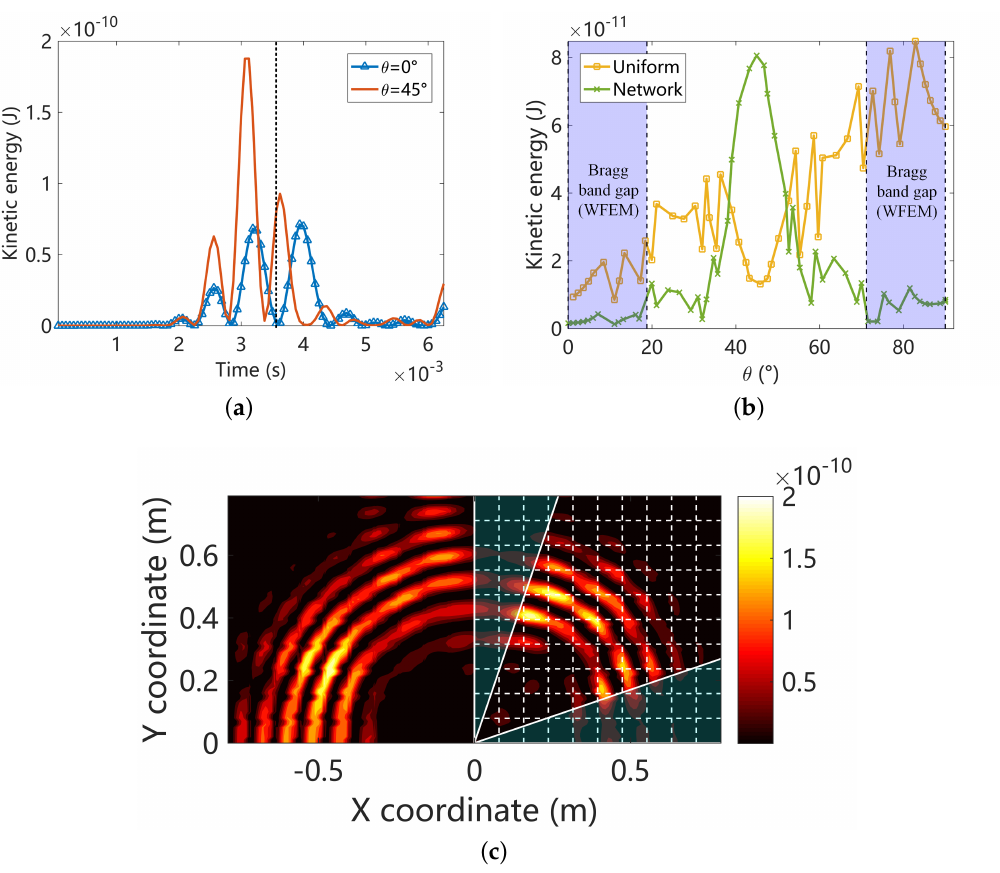
Figure 19. Summaries of the forced response results at 900Hz: ( a ) the time-history of the element kinetic energies at the monitor points with propagation angle θ = 0 and θ = π /4 in the piezoelectric composite; ( b ) The angular distribution of the instantaneous element kinetic energy at the monitor points; ( c ) The distribution of the instantaneous kinetic energy of the whole structure (only the upper half is shown due to symmetry). In Figure 19b,c, the results are obtained at the same time point t = 3.6 × 10 − 3 s marked by the dotted line in Figure 19a, and the identified band gap angles are highlighted by the blue areas.